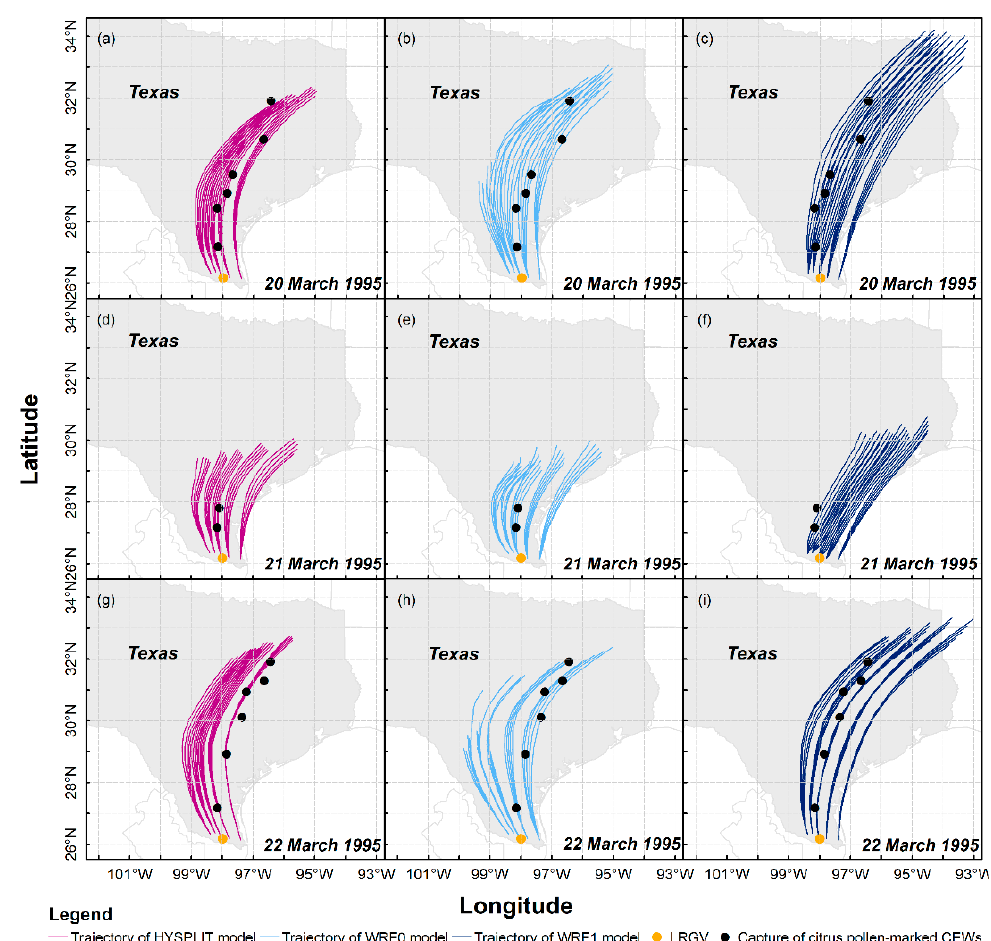
Figure 4. Migration trajectories of H. zea migrants (CEWs) simulated by three trajectory analysis models. The starting points of each trajectory, i.e., source sites, are listed in Figure 1.